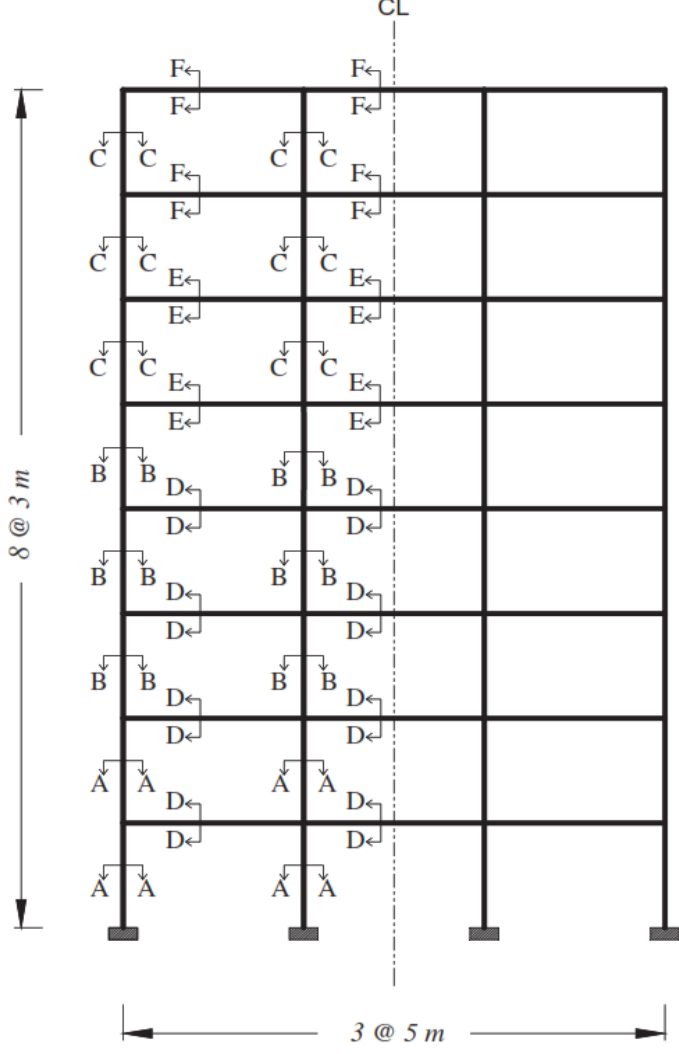
Figure 2. Selected moment ‐ resisting frame [7,28].